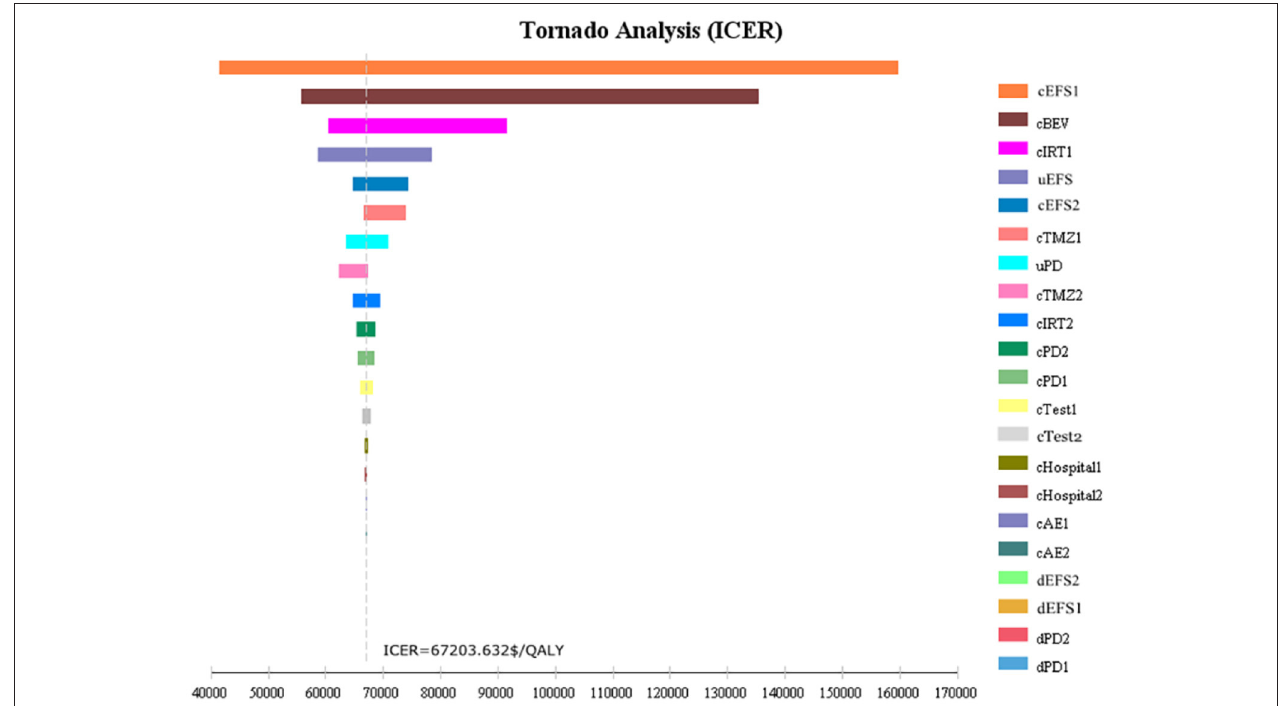
FIGURE 3 | Tornado diagram of one-way sensitivity analysis.